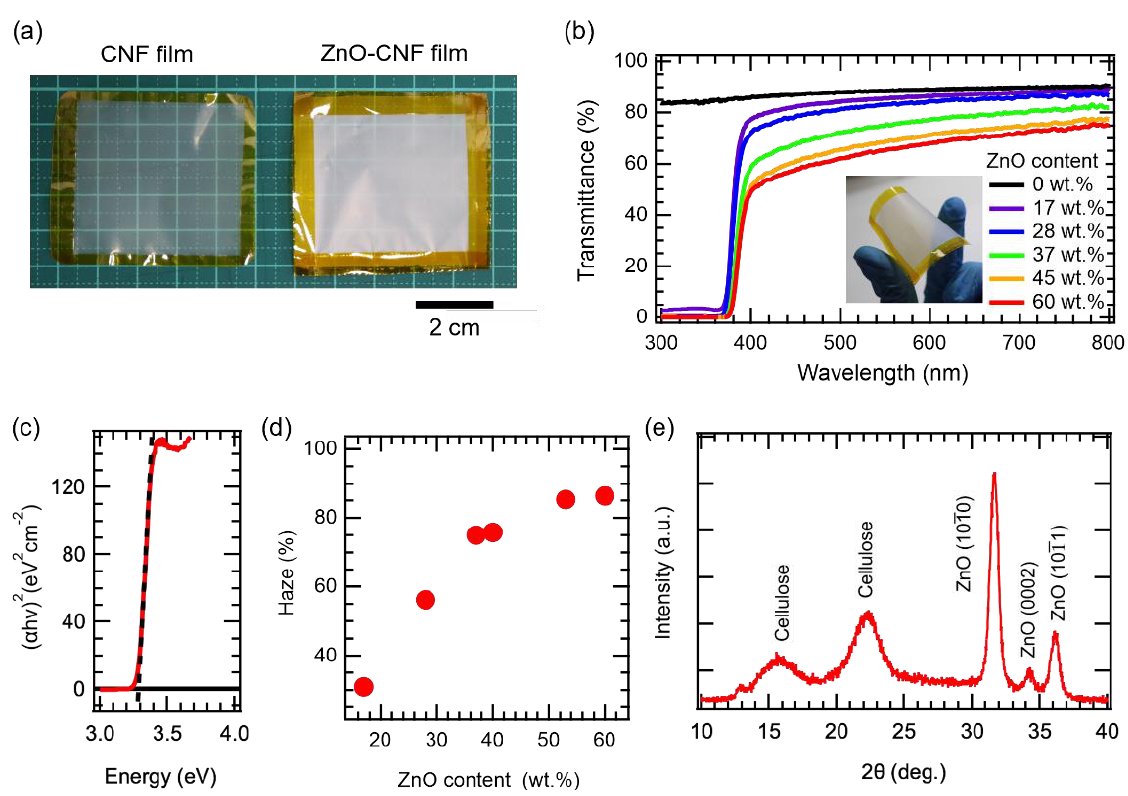
Figure 1. ( a ) Digital photographs and ( b ) optical transmittance spectra of the CNF film without ZnO NPs and ZnO–CNF nanocomposite films. Inset: digital photograph of a curved freestanding film with 37wt.% ZnO. ( c ) Tauc plot of the nanocomposite film with 17 wt.% ZnO NPs. ( d ) Haze values of the nanocomposite films as a function of the ZnO content. ( e ) Typical XRD pattern of the nanocomposite films (ZnO content: 17